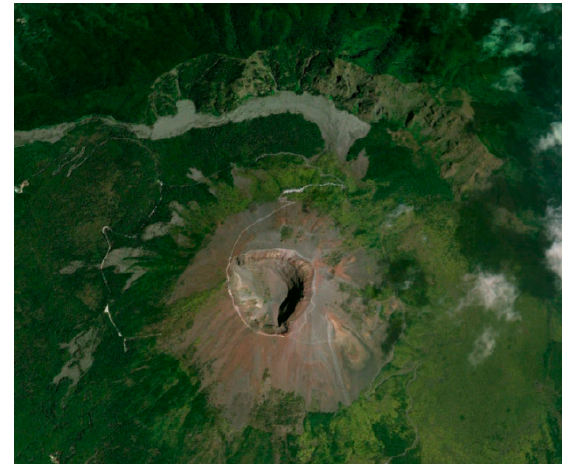
® acquired on 29 July 2010: plants